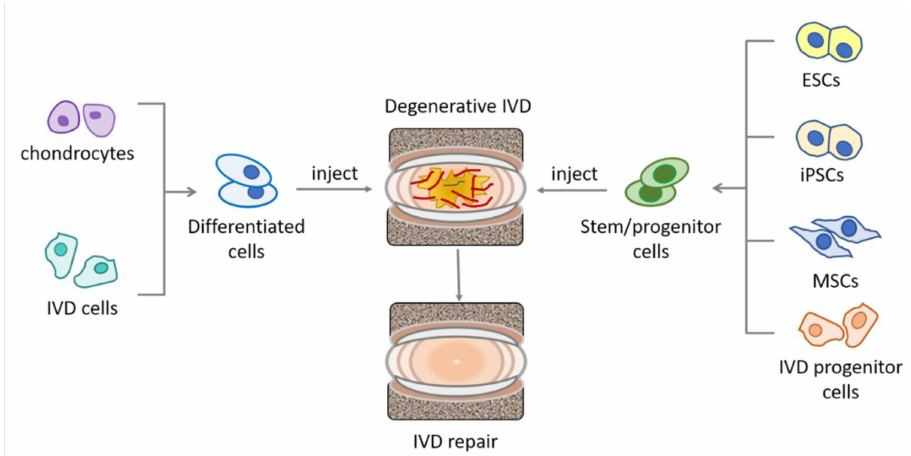
Figure 2. Sources of different cell types for IVD repair. Differentiated cells, including chondrocytes and IVD cells, and stem/progenitor cells, including ESCs, MSCs, iPSCs, and the recently identified IVD progenitor cells, have been explored for IVD repair. MSCs: mesenchymal stem cells; ESCs: embryonic stem cells; iPSCs: induced pluripotent stem